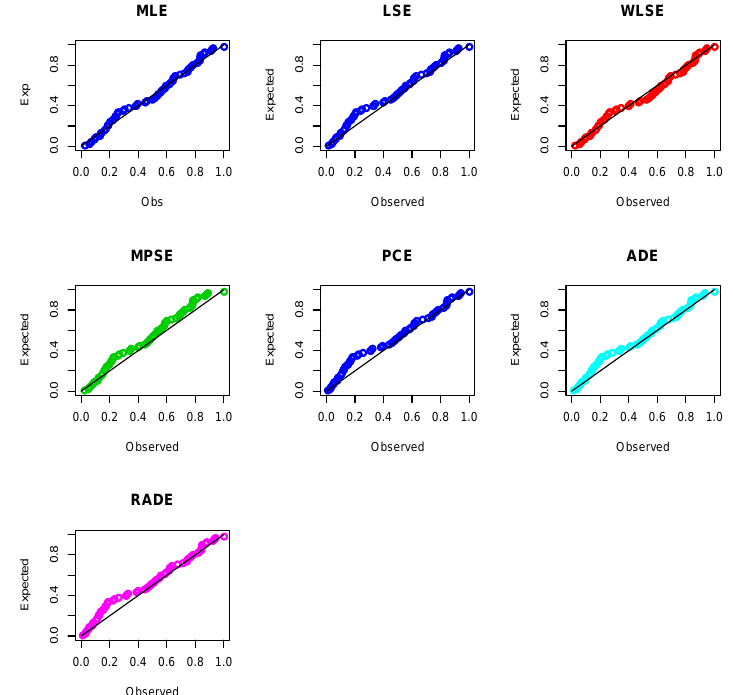
Figure 3. The PP plots of the omega distribution based on seven methods of